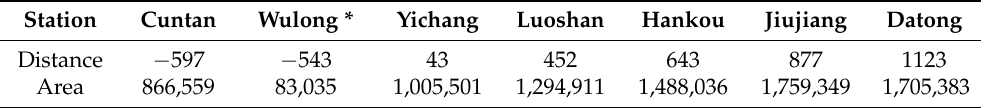
Figure 1. Map showing locations of the Yangtze River (blue thick line), 7 gauging stations (black triangle points), 206 meteorological stations (black circle points), and the Three Gorges Dam (TGD). Table 1. The distances of the gauging stations from the TGD (km) and their drainage area (km 2 ). A negative distance value indicates that the gauging station is located upstream from the TGD, and a positive value indicates the gauging station is located downstream from the TGD. (* Wulong gauging station is located on the Wu River, a tributary of the Yangtze River).